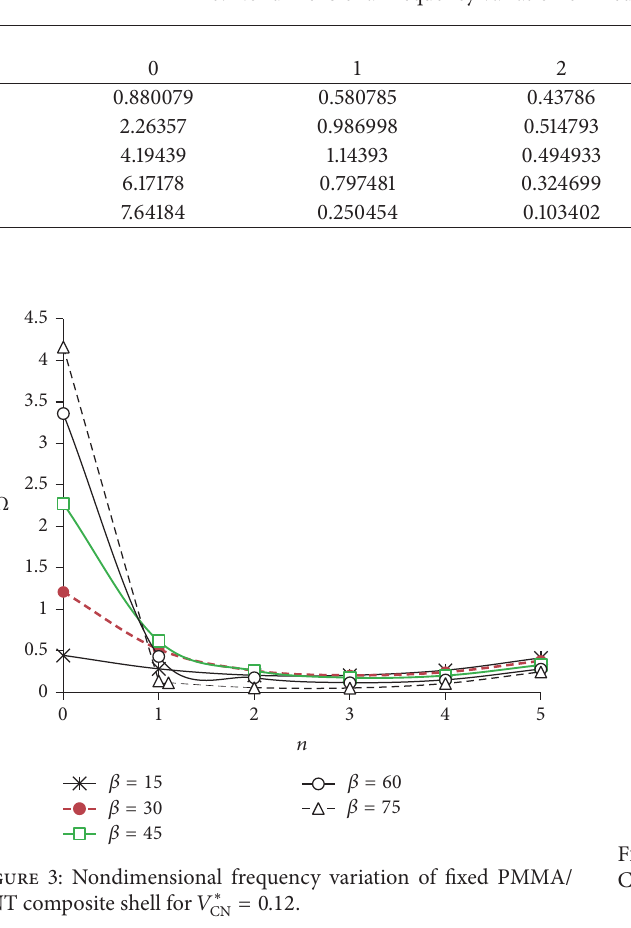
Table 6: Nondimensional frequency variation of fixed PMMA/CNT composite shell for 𝑉 ∗ CN = 0.28 .